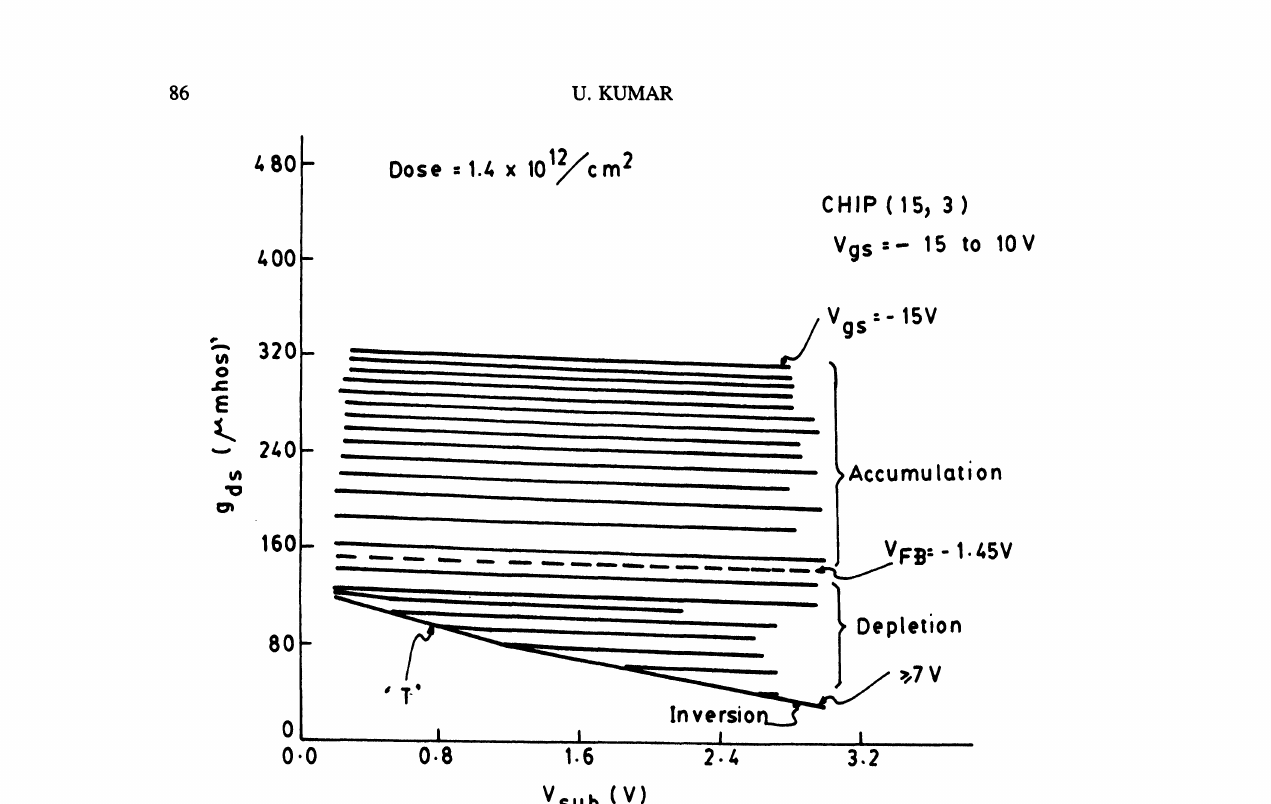
FIGURE 9 Typical gds Vsub plots of buried channel MOSFET exhibiting various modes Vds 0 (plotted by the data acquisition